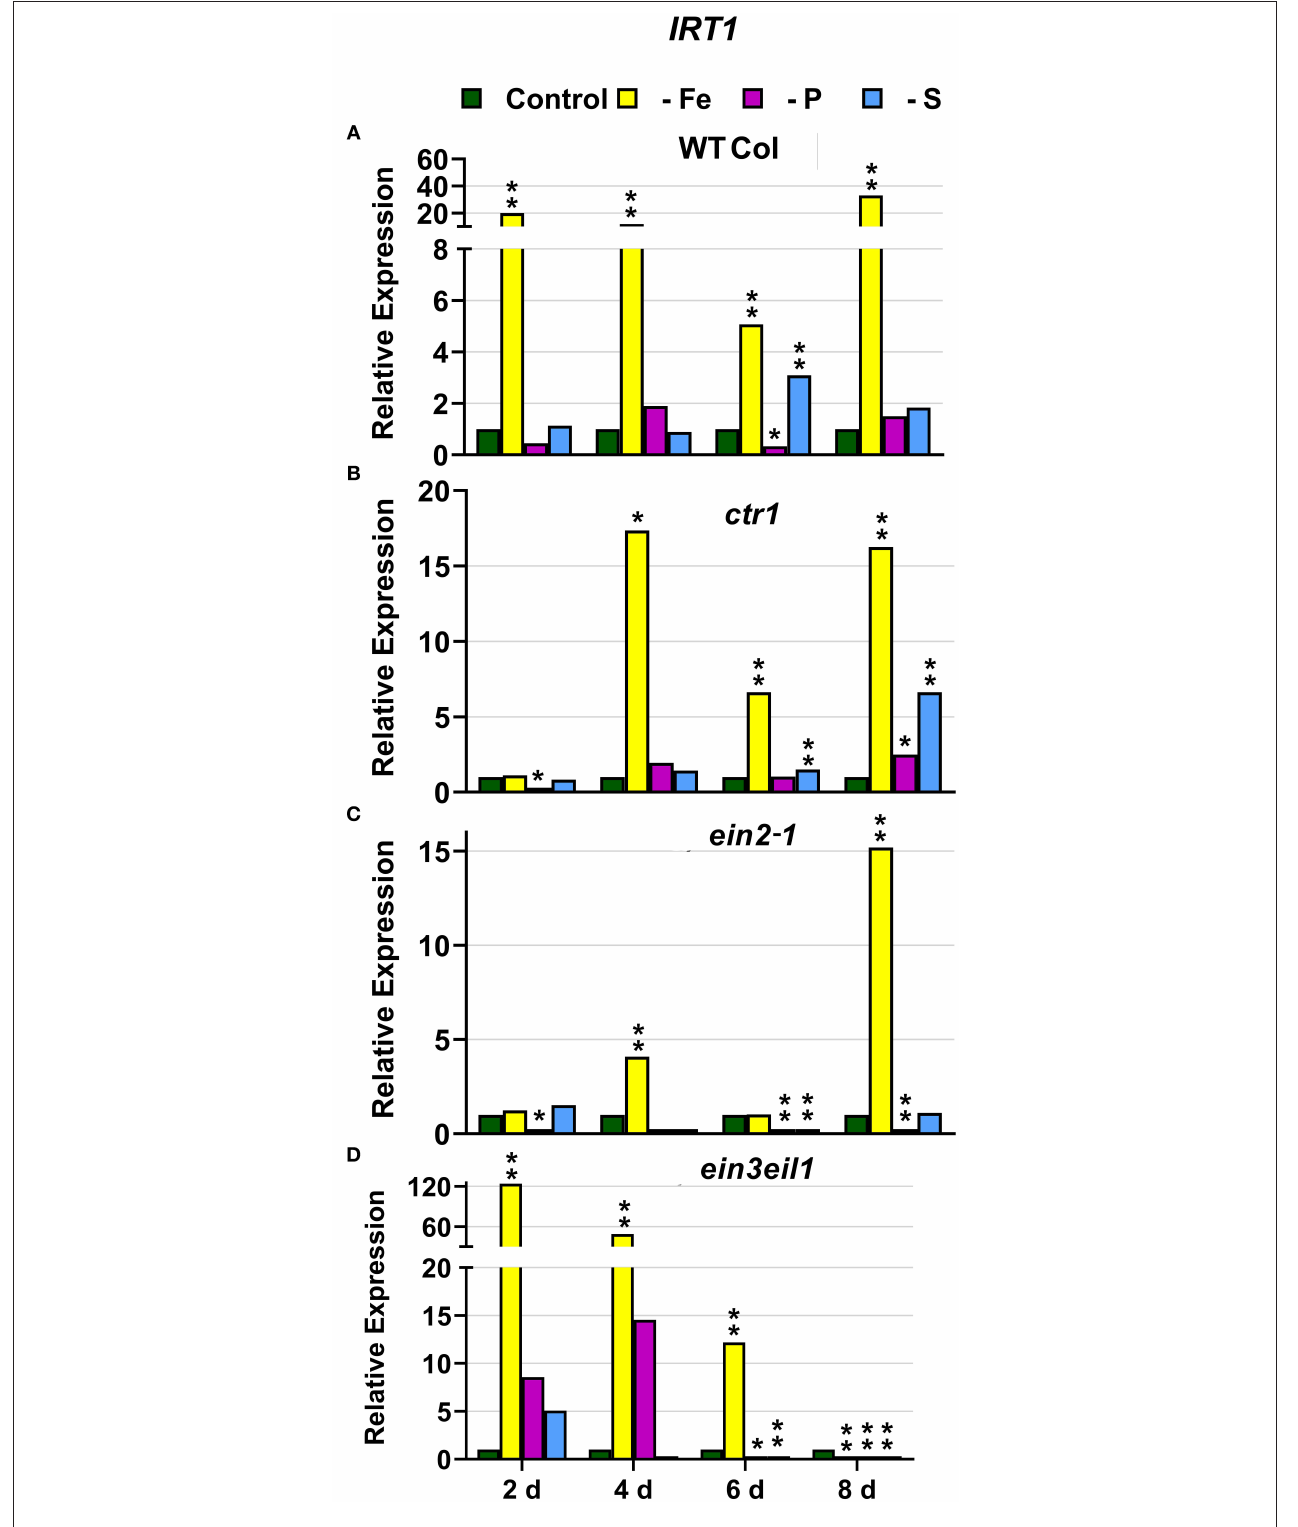
FIGURE 2 | Effect of Fe, P or S deficiency on the expression of the Fe-related gene IRT1 in roots of the Arabidopsis WT Columbia and its ethylene mutants ctr1 , ein2-1 and ein3eil1 (A–D) . Treatments and gene expression determination as in Figure 1 . Within each day and genotype, * or ** indicate significant differences ( P < 0.05 or P < 0.01) in relation to the control